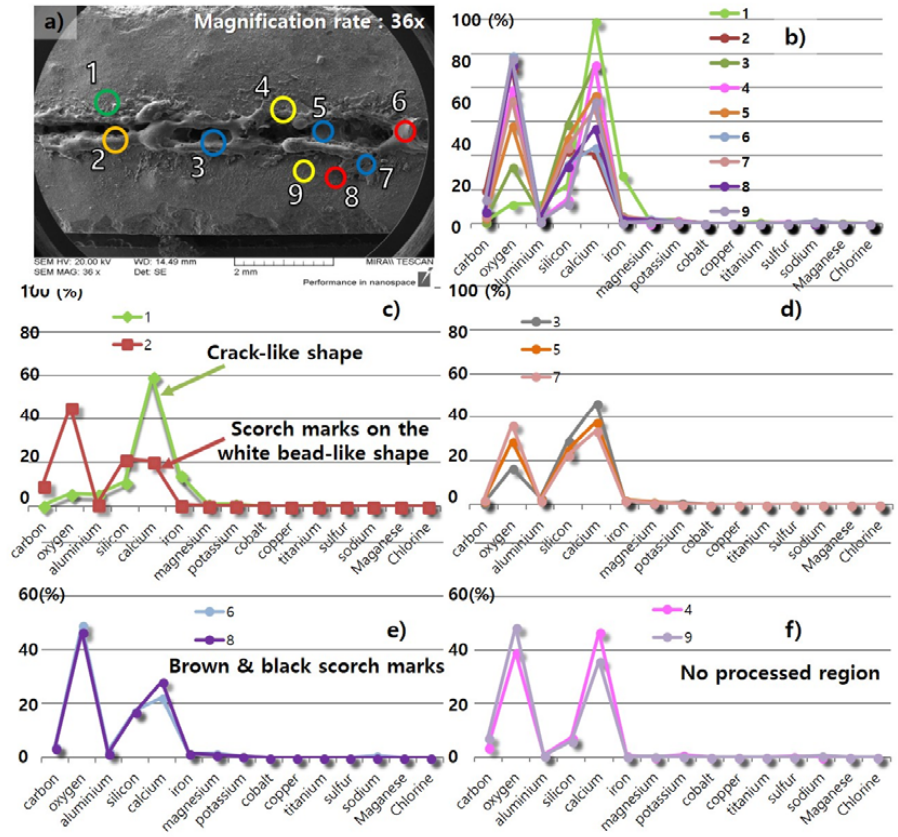
Figure 14. EDX analysis of LU-I with a cutting speed of 4 m/min, ( a ) measured points of white bead-like shape (Blue), brown and black scorch marks (Red), crack-like shape (Green), and scorch marks on the white bead-like shape (Orange); ( b ) comparison of all measured points; ( c ) component distribution of the crack-like shape and scorch marks on the white bead-like shape; ( d ) component distribution of the white bead-like shape; ( e ) component distribution of the brown and black scorch mark; ( f ) component distribution of non-processed